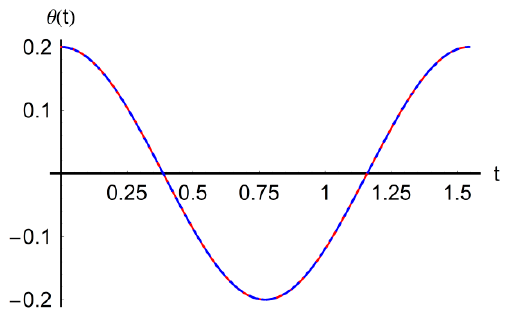
Figure 20. Comparison between the approximate solution (50) and numerical integration results for A = 0.4, L = 0.6. _____ numerical_ _ _ _approximate solution.